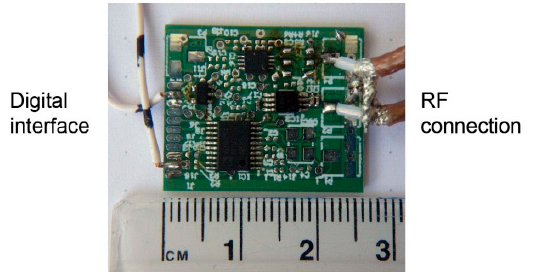
Figure 6. Bioimpedance sensor frontend: Frequency divider, DDS, and mixer.